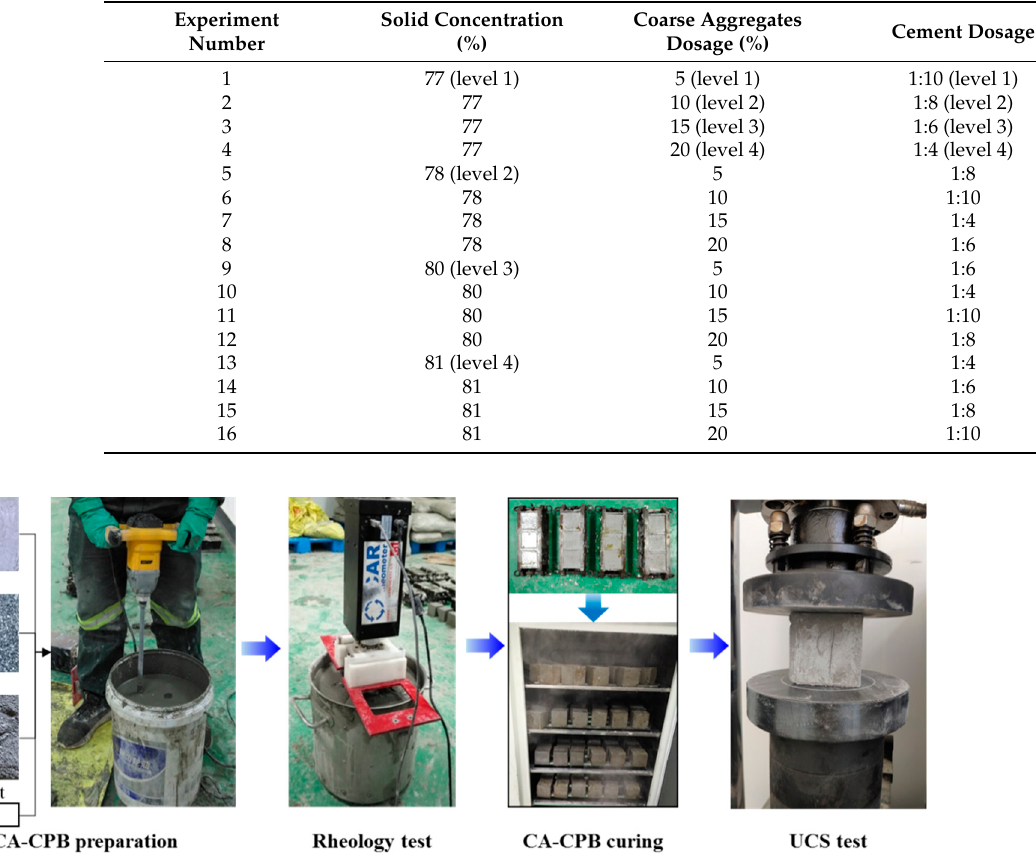
Table 4. Orthogonal experimental table L 16 (4 3 ).